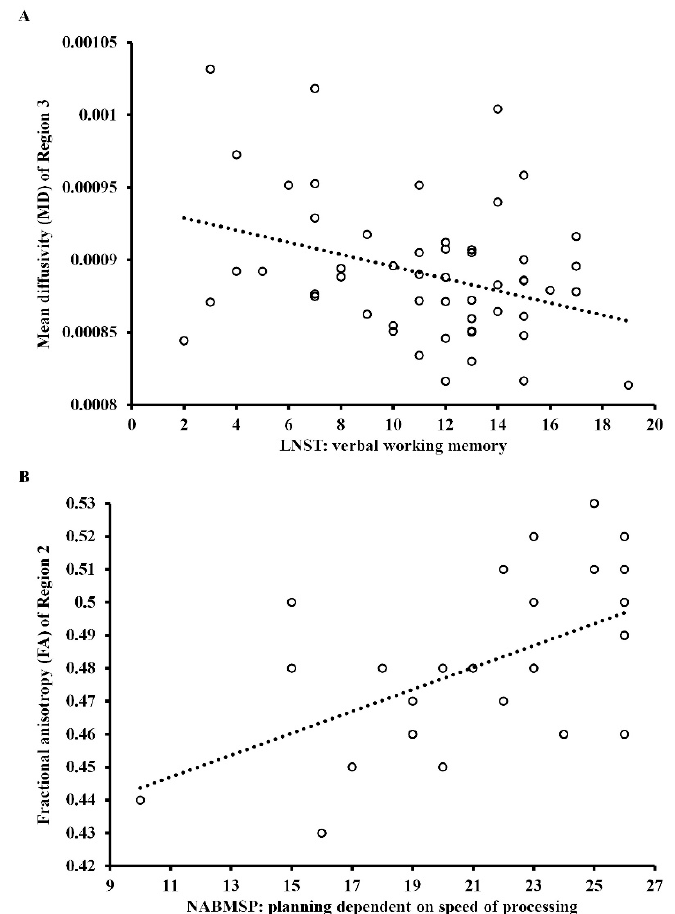
Figure 4. Scattergram for the relationship between: ( A ) mean diffusivity and verbal working memory in patients with chronic schizophrenia and ( B ) fractional anisotropy and planning dependent on speed of processing in healthy controls.